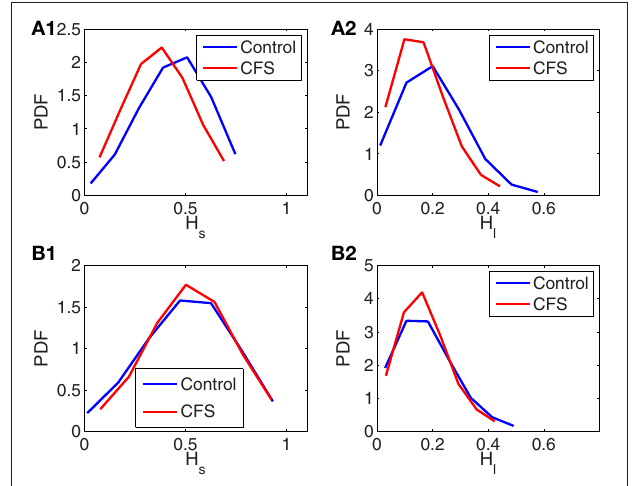
FIGURE 3 | Probability density functions (PDFs) for H s and H l of control and CFS subjects, where (A1, A2) are for data measured before the TSST, and (B1, B2) are for data measured during the stress tests.